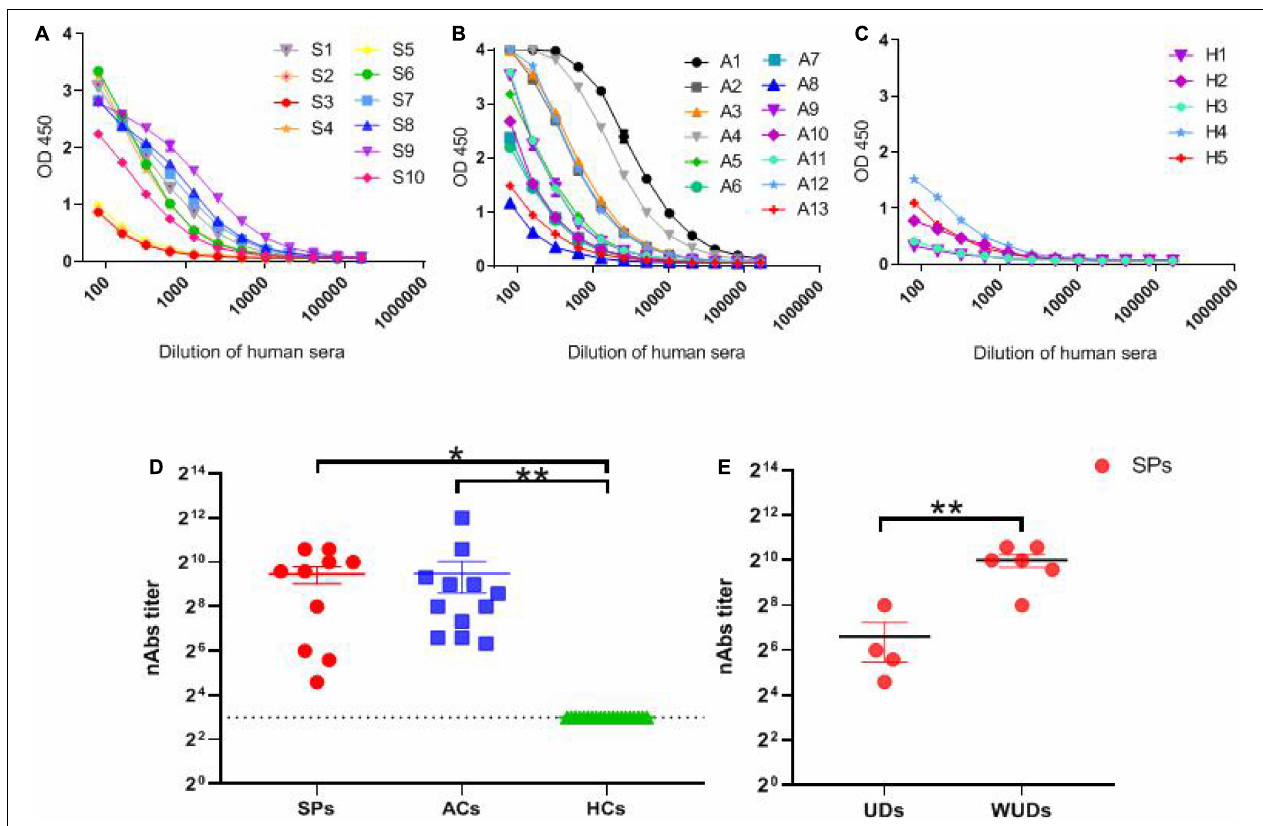
FIGURE 7 | SARS-CoV-2-specific IgG and nAb response in SPs, ACs, and HCs. (A–C) 1 µ g/ml RBD coating, OD 450 values with the dilution of human sera. (A) SPs. (B) ACs. (C) HCs. (D) Comparison of the level of nAbs in SPs, ACs, and HCs. (E) Comparison of the level of nAbs between patients with underlying diseases (UDs) and patients without underlying diseases (WUDs) in both SPs. Data are presented as means ± SEM. * P < 0.05, ** P <